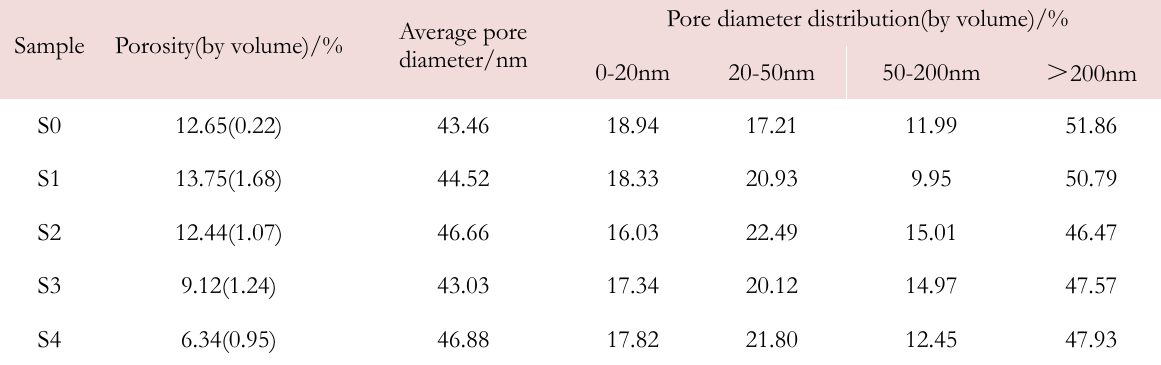
Table 4: Pore diameter distribution(standard deviations in